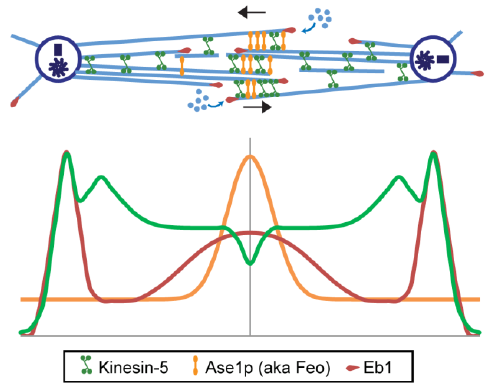
Figure 4. Anaphase B spindle in a Drosophila embryo. The upper drawing of the anaphase B spindle has a pole–pole axis corresponding with that of the drawing below showing the relative distribution of kinesin-5 motors, Ase1p crosslinkers, and the plus end binding protein Eb1 along the spindle (adapted from